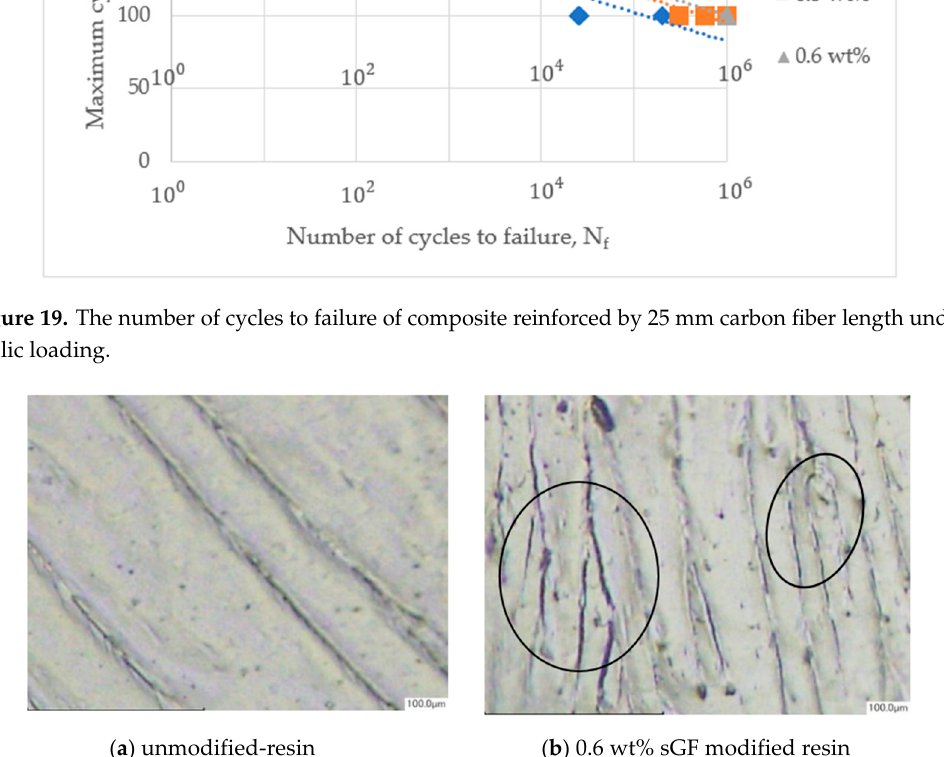
Figure 20. The laser microscope images of unmodified and modified resin specimens after compact tension test, showing the deflection of micro-cracks [25].